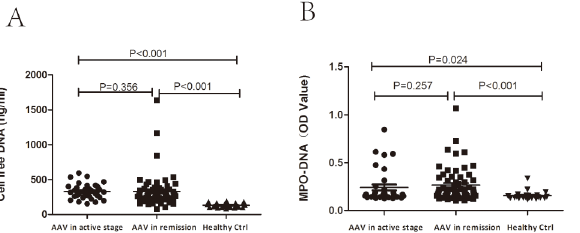
Fig 1. Serum levels of NETs in AAV patients in active stage and remission. A. Quantification of cell free DNA using Quant-iT PicoGreen assay in serum samples from healthy donors (n = 22), individuals with AAV in remission (n = 62) and with active disease (n = 34). B. Quantification of NETs in the serum samples by MPO-DNA complex ELISA. The mean optical density as measured by capture ELISA.